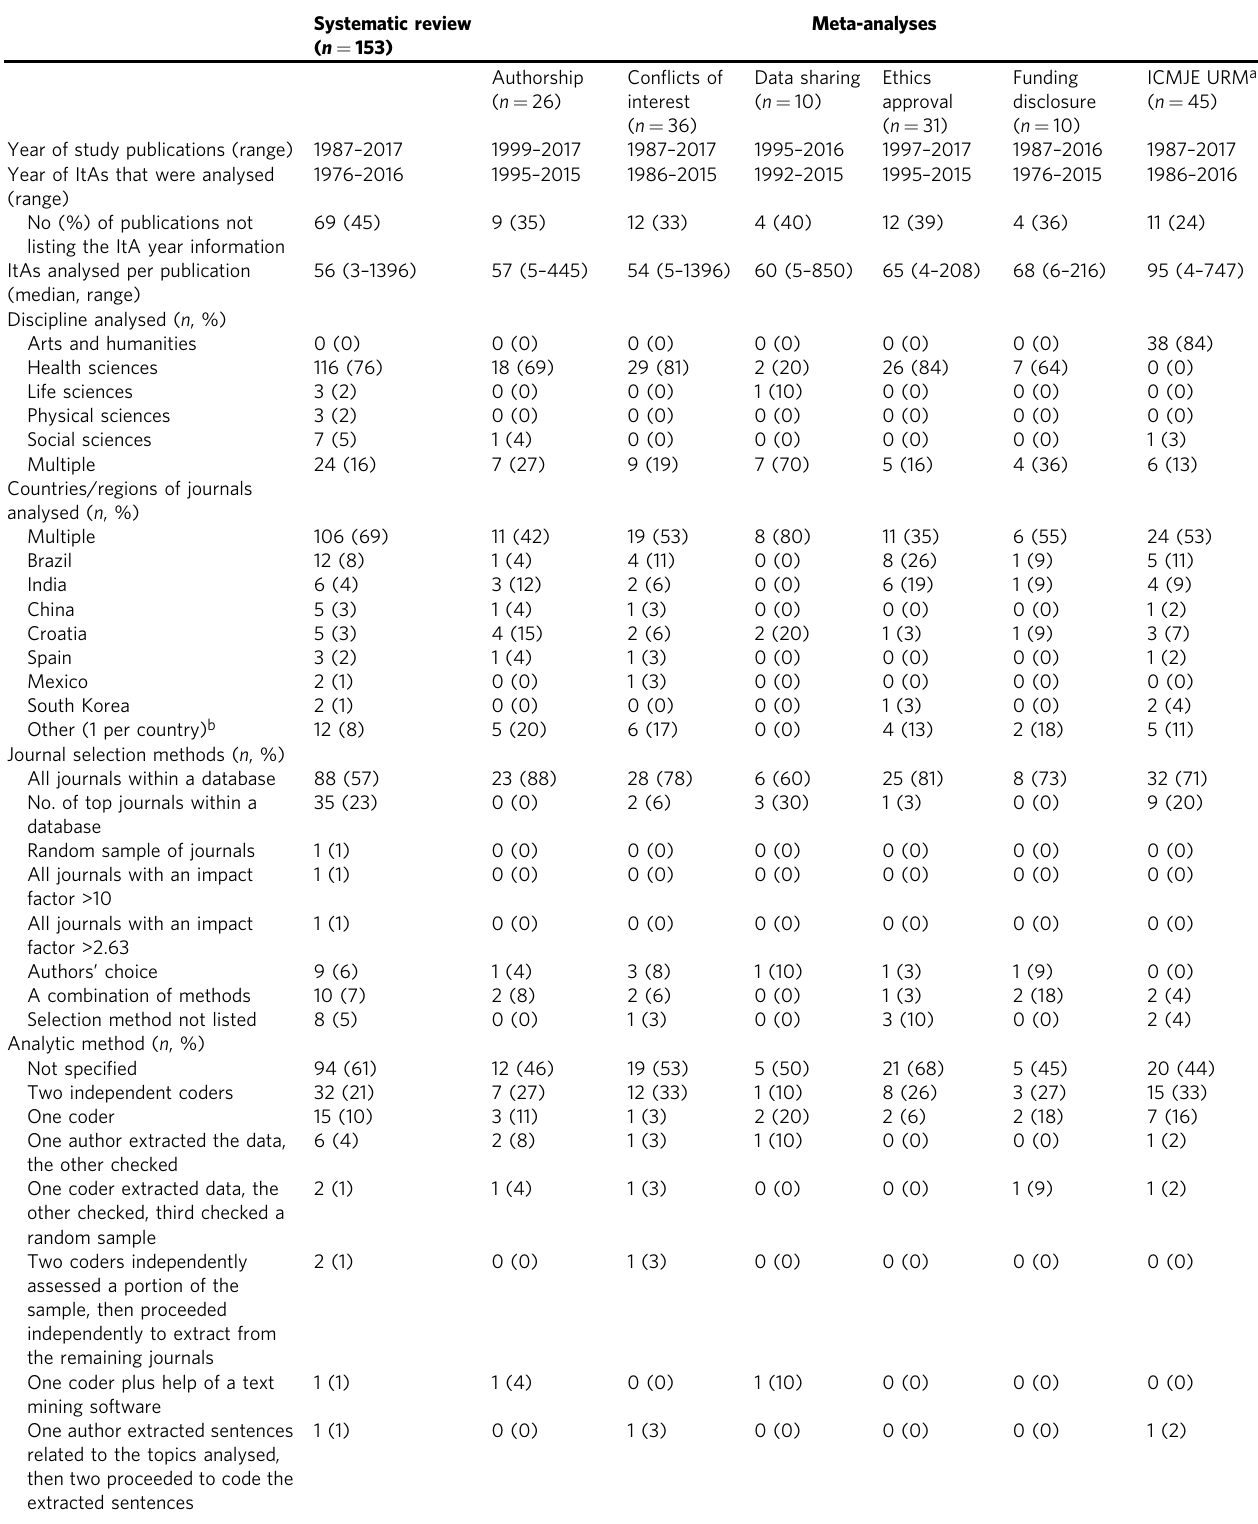
Table 1 Characteristics of studies that analysed Instructions to Authors (ItAs) included in the systematic review, as well as those meta-analysed per speci fi c